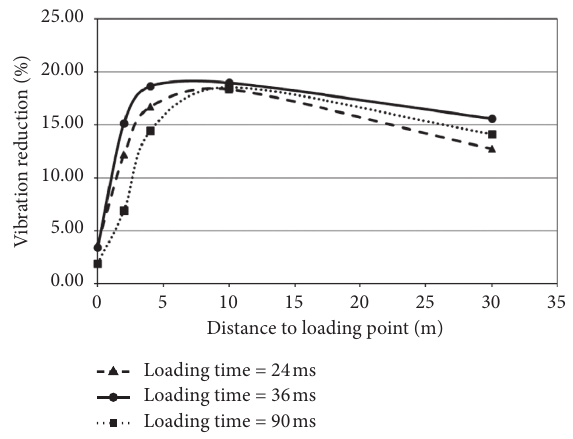
Figure 5: Sensitive analysis for varying traffic loads.